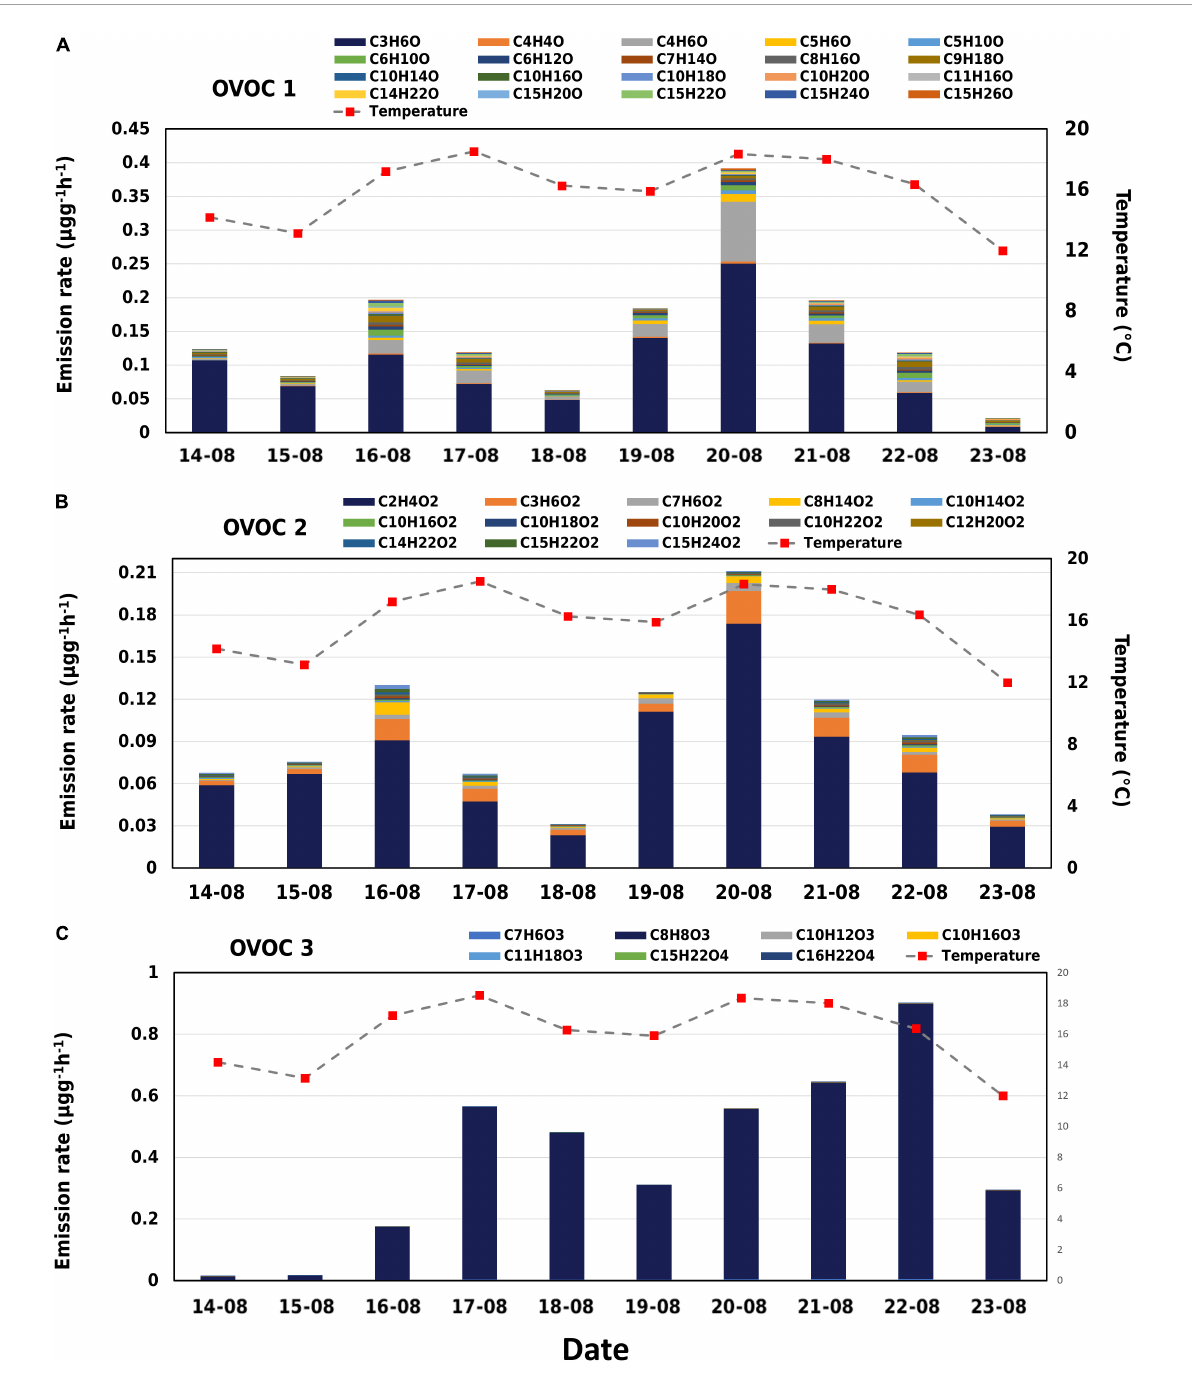
FIGURE5 Emissions of the oxygenated compounds split into different classes measured from 14 August 2019 to 23 August 2019. (A) OVOC class 1 consists of compounds with 1 oxygen atom. (B) OVOC class 2 consists of compounds with 2 oxygen atoms. (C) OVOC class 3 consists of compounds with 3 or more oxygen